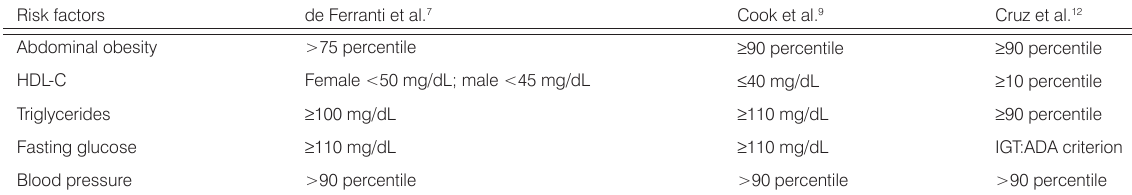
Table 2. Published definitions of MS in